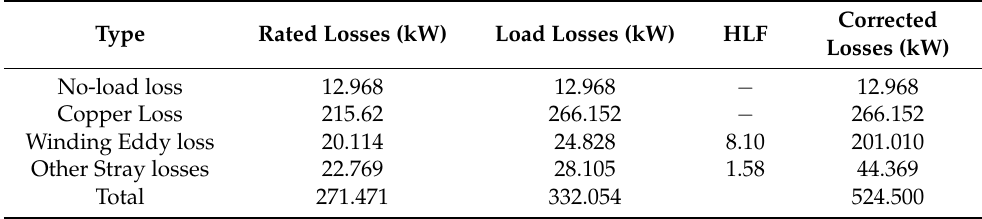
Table 9. Computation of the harmonic loss